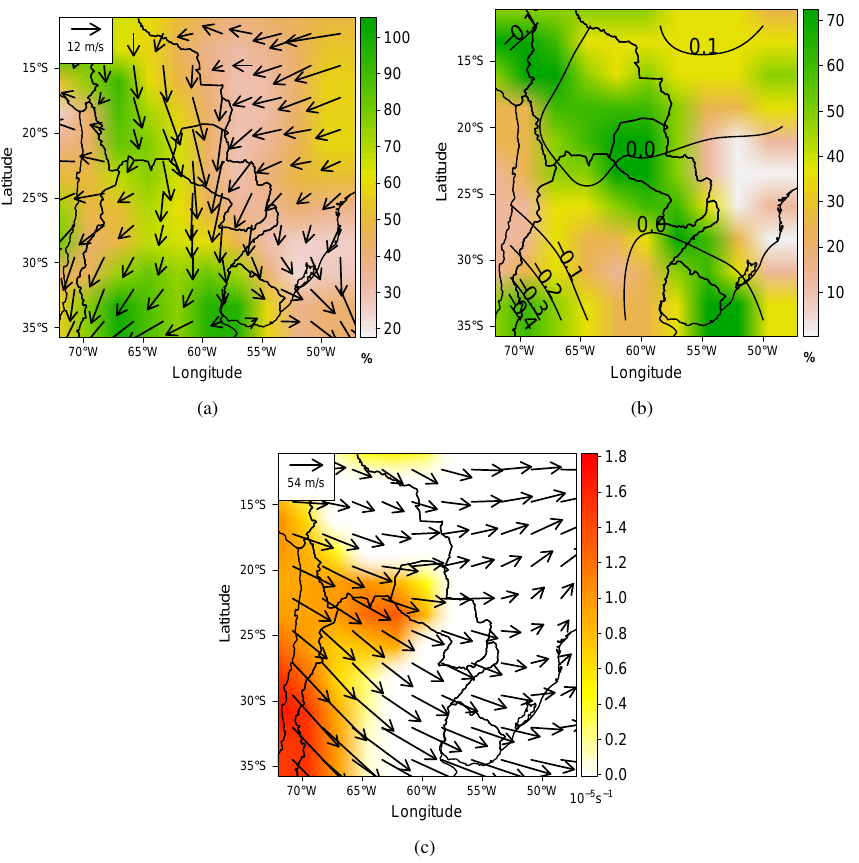
Fig. 6. Large-scale fields on 12 September 2007 at 06:00UTC: (a) wind and relative humidity at 850hPa; (b) mean 700–500hPa relative humidity (shaded) and ω at 500hPa (contour); (c) wind and divergence at 200hPa. Fig. 6: Large-scale fields on 12 September 2007 at 06:00 UTC: (a) wind and relative humidity at 850 hPa; (b) mean 700-500 hPa relative humidity (shaded) and ω at 500 hPa (contour); (c) wind and divergence at 200 hPa.